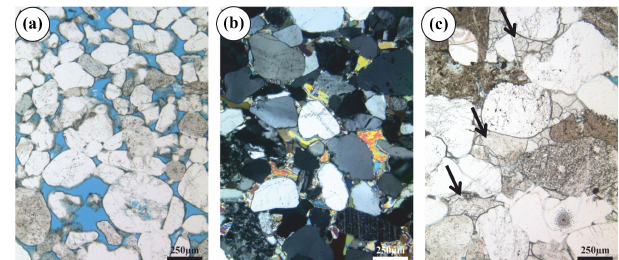
Figure 3. Thin-section images with 50 × magnification given differ- ent diagenetic features (pore-filling cements) of the sandstone sam- ples. In (a) a transmitted light image of a sample with free pore space is shown (blue represents open pore). In (b) an image of a thin section with crossed nicols is shown, highlighting pore-filling anhydrite cement (rainbow colours). In (c) a transmitted light im- age of a thin section with pore-filling carbonate cement is shown (arrows).